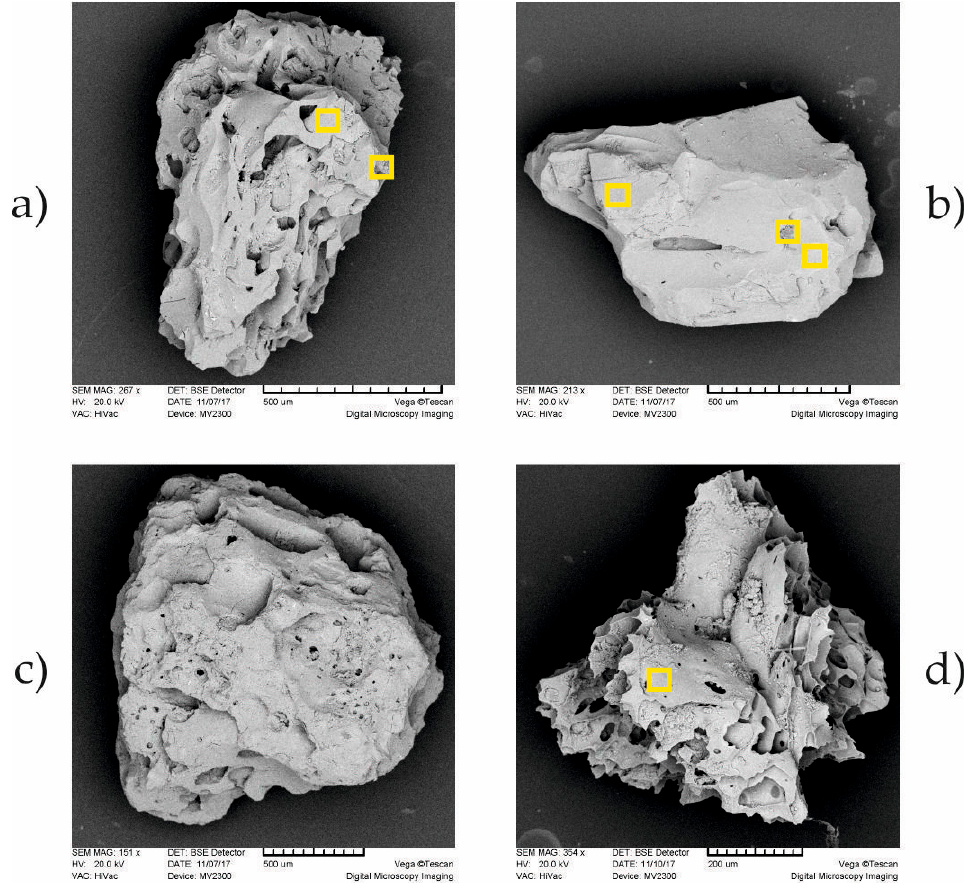
Figure 4. Scanning electron microphotographs of the basalt and andesitic basalt ash shards from the core unit of 323–340 cm: ( a ) vesicular black basalt glass with a SiO 2 content of 49.10–57.15% in the sample of 323–325 cm, ( b ) massive black semi-transparent glass with a SiO 2 content of 49.45% in the sample of 323–325 cm, ( c ) vesicular black shard (SiO 2 content of 50.22%) with cavities filled with the andesitic (SiO 2 content of 55.79%) and persilicic (SiO 2 content of 63.89–65.97%) dust in the sample of 323–325 cm, ( d ) highly vesicular dark-green semi-transparent andesitic basalt glass with a SiO 2 content of 52.52% in the sample of 334–336 cm. Yellow-outlined rectangles show points of measurements. Angular transparent/subtransparent fragments of the persilicic glass were olive and bottle-green, elongate (columnar) with rough scratching on the surface parallel to the elongation or having an irregular shape, and aphanitic (Figure 5).